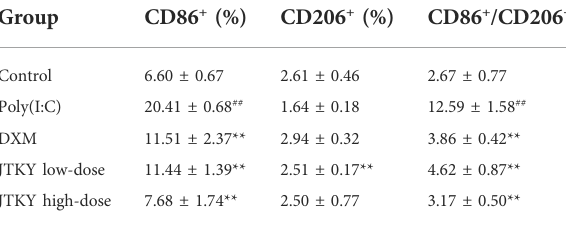
TABLE 3 Effects of JTKY on the proportion of Ly6G + CD11b + cells in BALF.